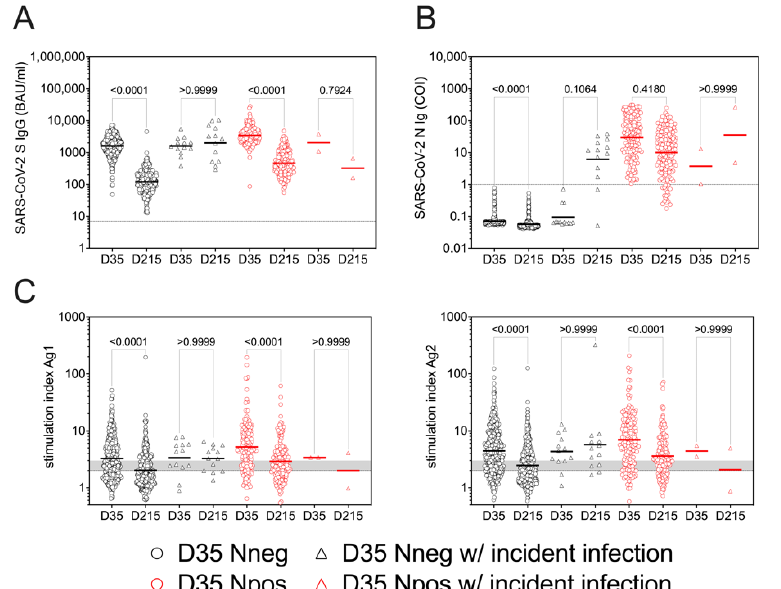
Figure 5. Effect of an incident infection before D215 on the vaccine induced SARS-CoV-2-specific immune response in D35 Nneg (black symbols) and Npos (red symbols) groups. Serum levels of SARS-CoV-2 S- ( A ) and N-specific ( B ) antibodies as well as T cell response represented by stimulation index (SI) to Ag1 and Ag2 ( C ) are shown in samples collected at D35 and D215 with (triangle) or without (circle) incident SARS-CoV-2 infection. Differences of immune parameters were tested by applying non-parametric Kruskal –Wallis test followed by Dunn’s multiple comparisons.